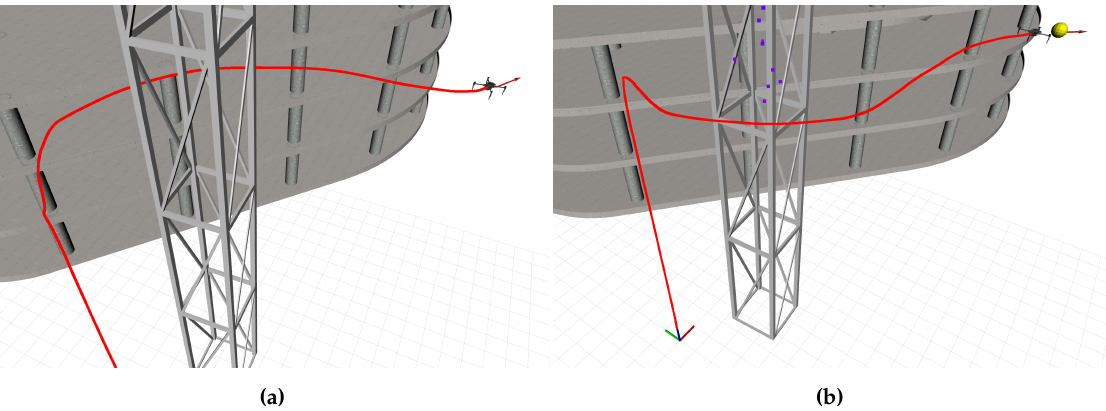
Figure 7. Two flight trajectories (red line) of the UAV avoiding collision with a crane soon after takeoff. ( a ) The trajectory shows a clockwise motion around the crane. ( b ) In another flight the crane was circumvented in a counter-clockwise